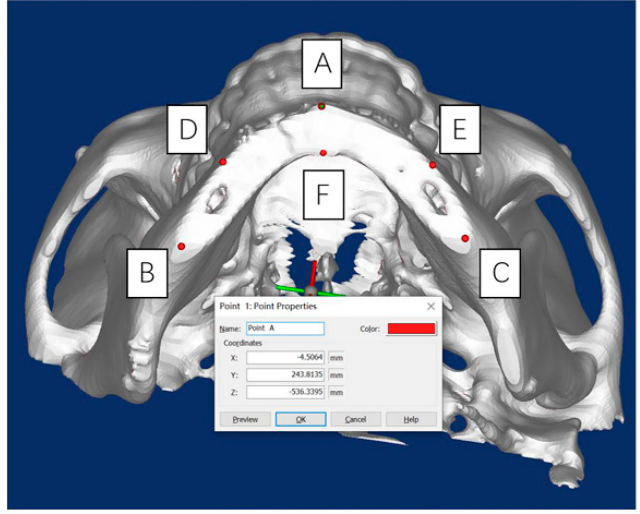
Figure 4. The locations of measuring points A, B, C, D, E, and F. At this time, using point A as an example, the spatial distance between the preoperative simulation and postoperative outcome at the same point could be